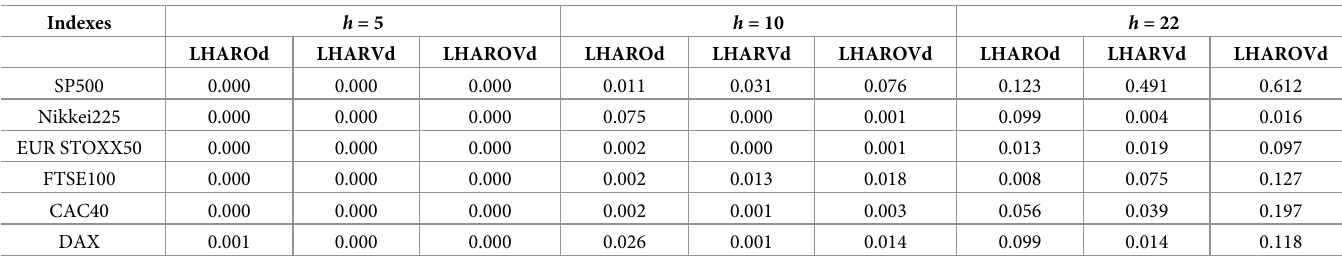
Table 8. The tests of forecasting performance comparation between daily lagged and long lagged models (long horizons).